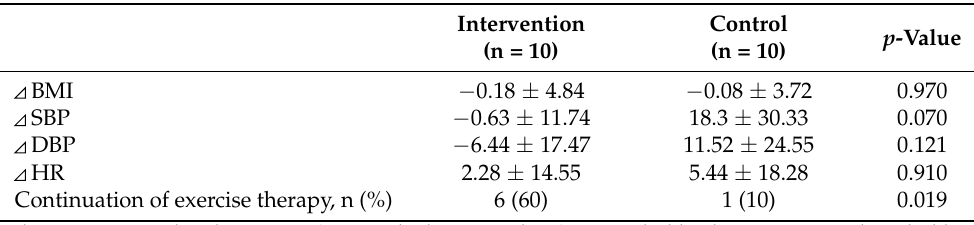
Intervention Control p -Value (n = 10) (n = 10)